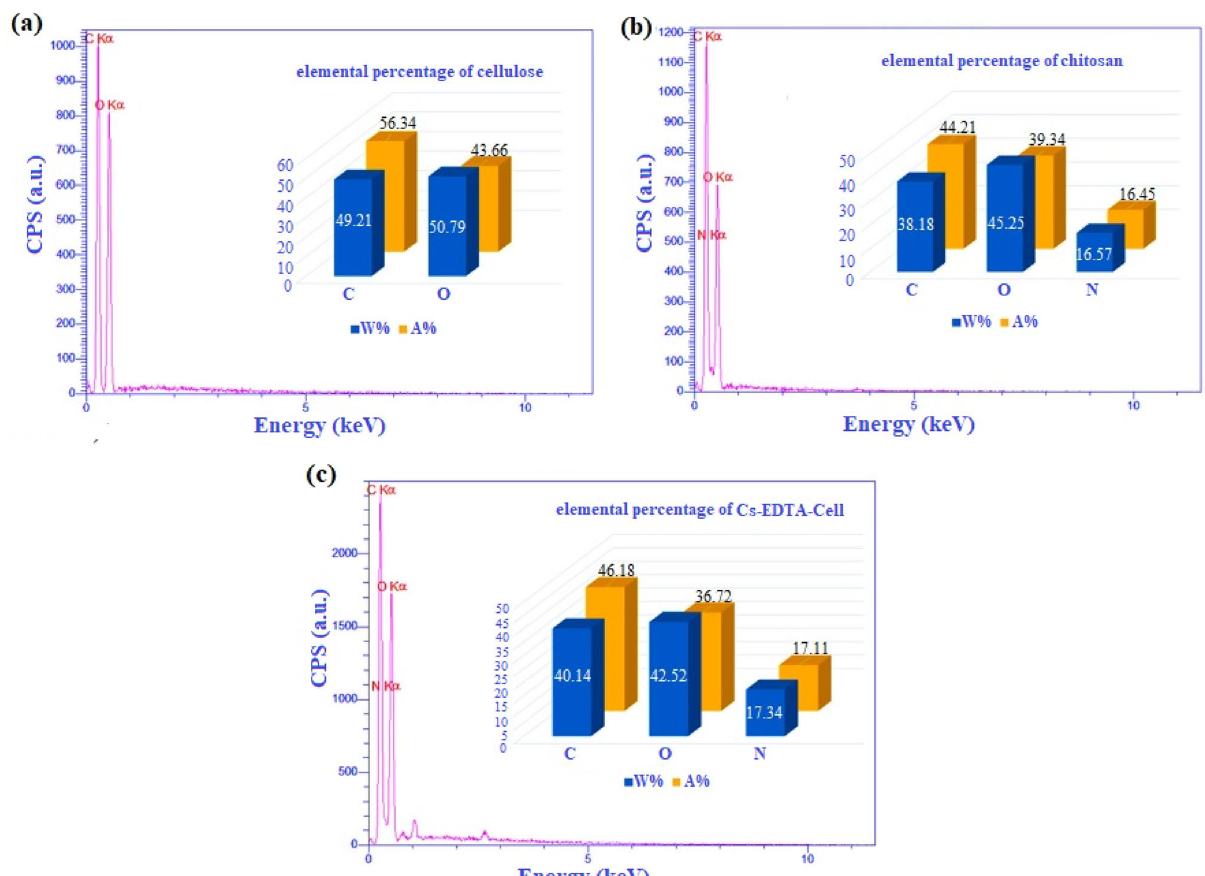
Figure 7. Energy-dispersive X-ray (EDX) spectroscopy pattern of cellulose ( a ), chitosan ( b ) and Cs-EDTA-Cell network ( 1 , c respectively (Fig. 7a–b). Indeed, EDX analysis of Cs-EDTA-Cell network ( 1 ) confirmed clearly the presence of C, N and O atoms (Fig. 7c). As can be seen from the obtained results by the EDX spectra, the presence of C, O and N peaks can be ascribed to the structure of chitosan and cellulose biopolymers as well as EDTA. Since EDTA contains two nitrogen atoms in its structure, increasing of the percentage of N in the Cs-EDTA-Cell network ( 1 ) indicates that cellulose has been successfully grafted to chitosan by the EDTA linker.